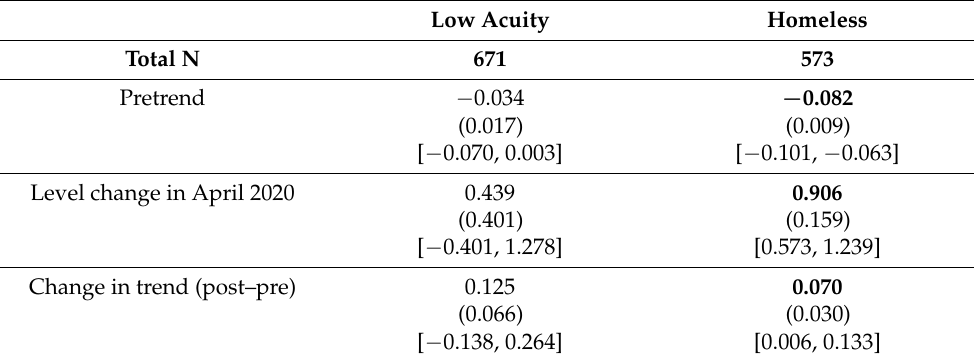
Table A2. OUD-Related ED Visit Characteristics by Race/Ethnicity: Hispanic